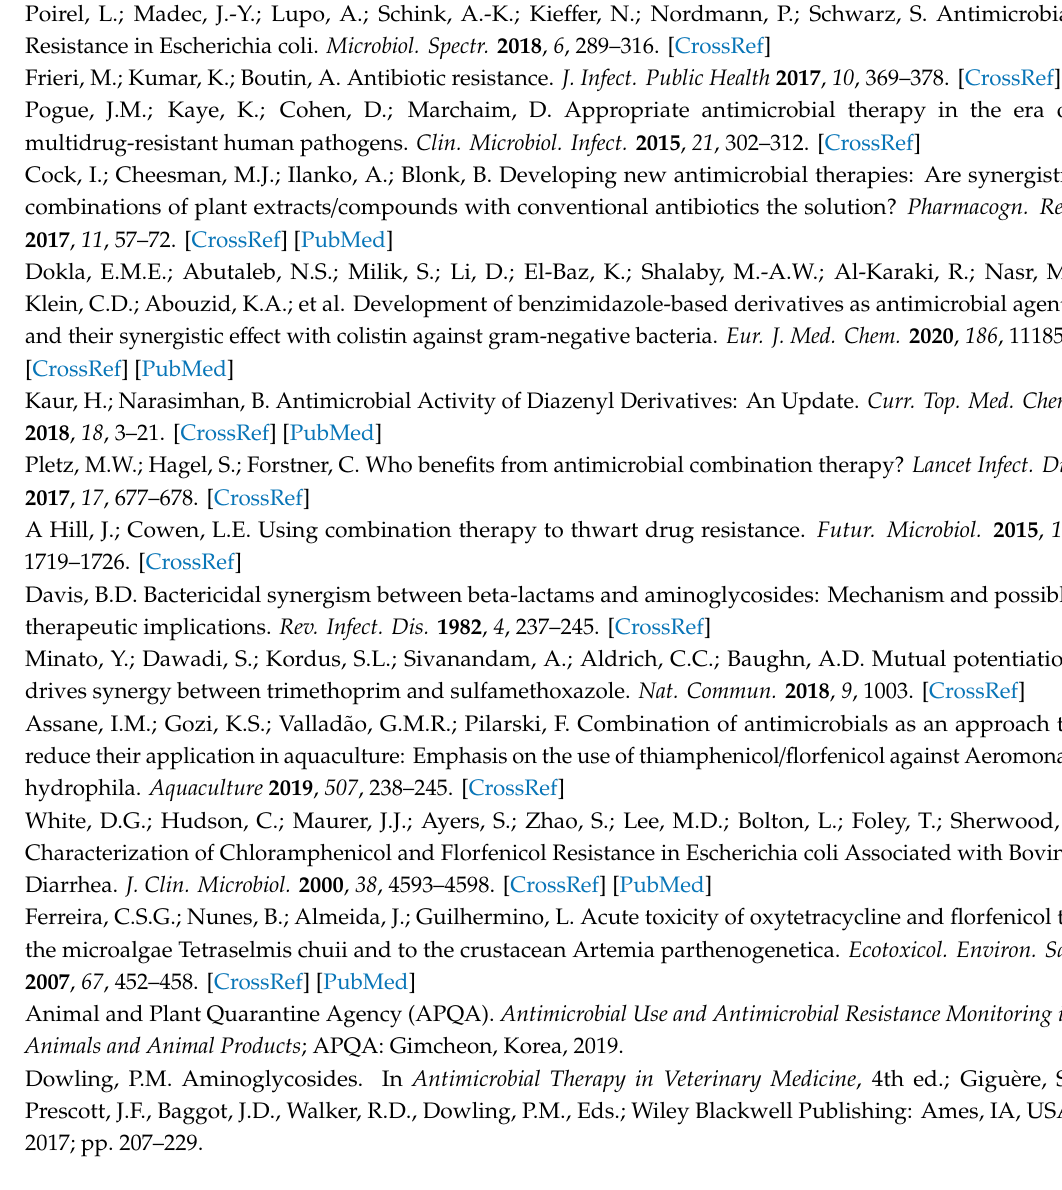
Table S1: In vitro synergy between cephalothin and gentamicin in combination against 11 multidrug-resistant E. coli isolates. Table S2: In vitro synergy between florfenicol and amikacin in combination against 11 multidrug-resistant E. coli isolates. Table S3: In vitro synergy between florfenicol and gentamicin in combination against 11 multidrug-resistant E. coli isolates. Table S4: In vitro synergy between chloramphenicol and gentamicin in combination against 11 multidrug-resistant E. coli isolates. Table S5: In vitro synergy between chloramphenicol and amikacin in combination against 11 multidrug-resistant E. coli isolates. Table S6: In vitro synergy between florfenicol and cephalothin in combination against 11 multidrug-resistant E. coli isolates. Table S7: Minimum inhibitory concentrations (MICs) of 16 antimicrobial agents against 12 E. coli isolates used in this